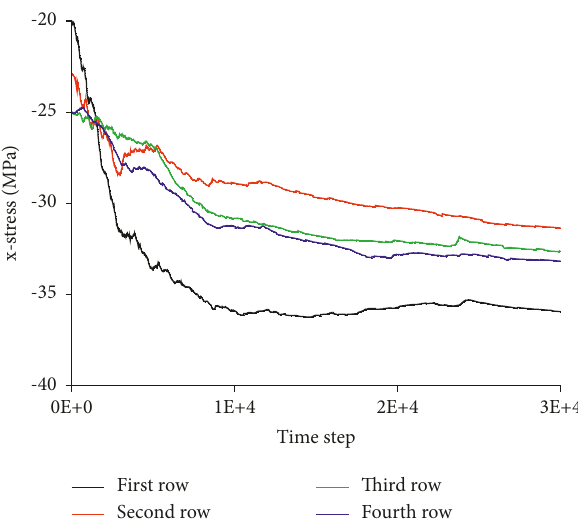
Figure 18: Average shear stress of upper soil.